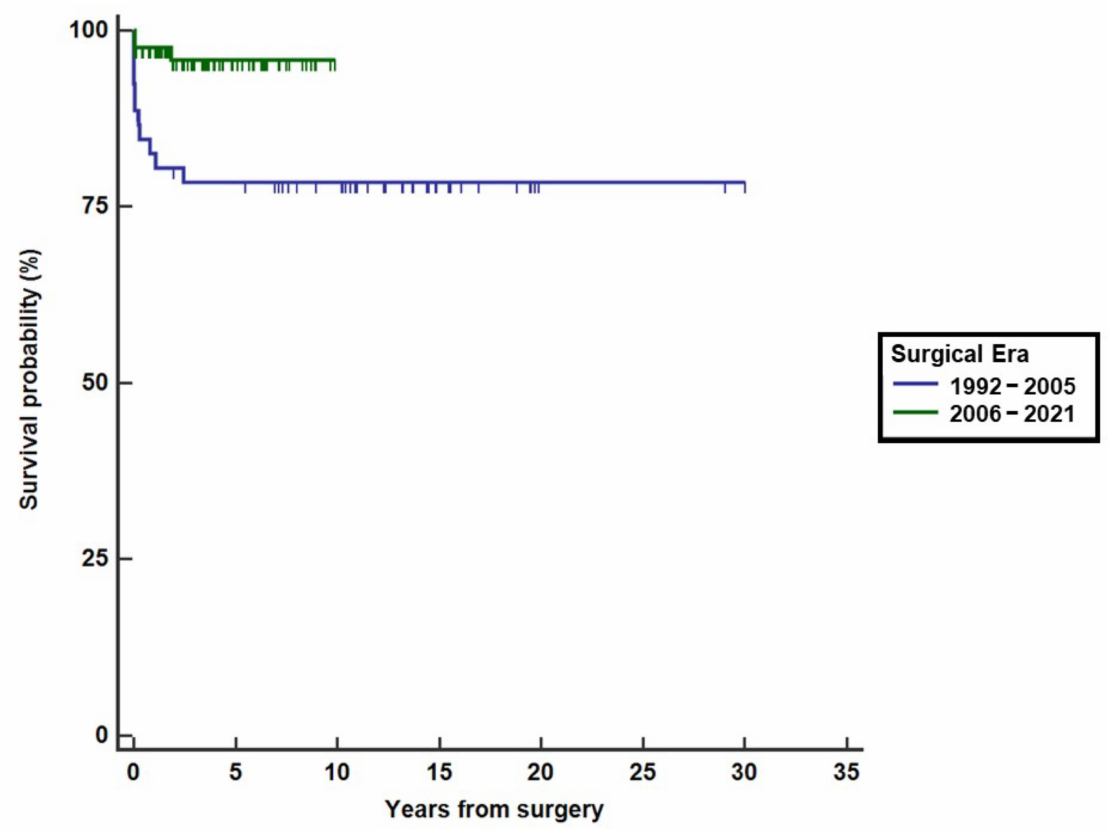
Figure 3. Survival by the era of all treated patients with